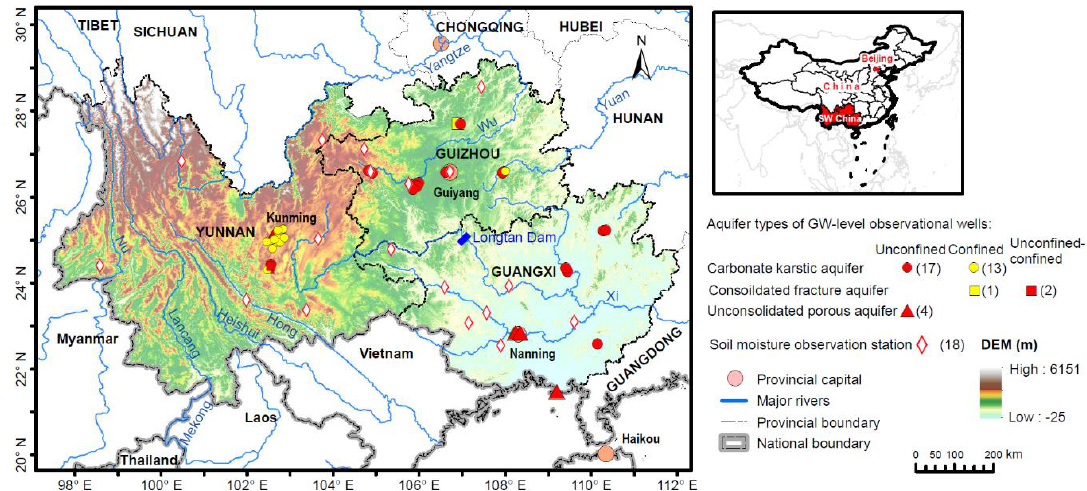
Figure 1. Study region and location of in situ groundwater-level and soil moisture observations.